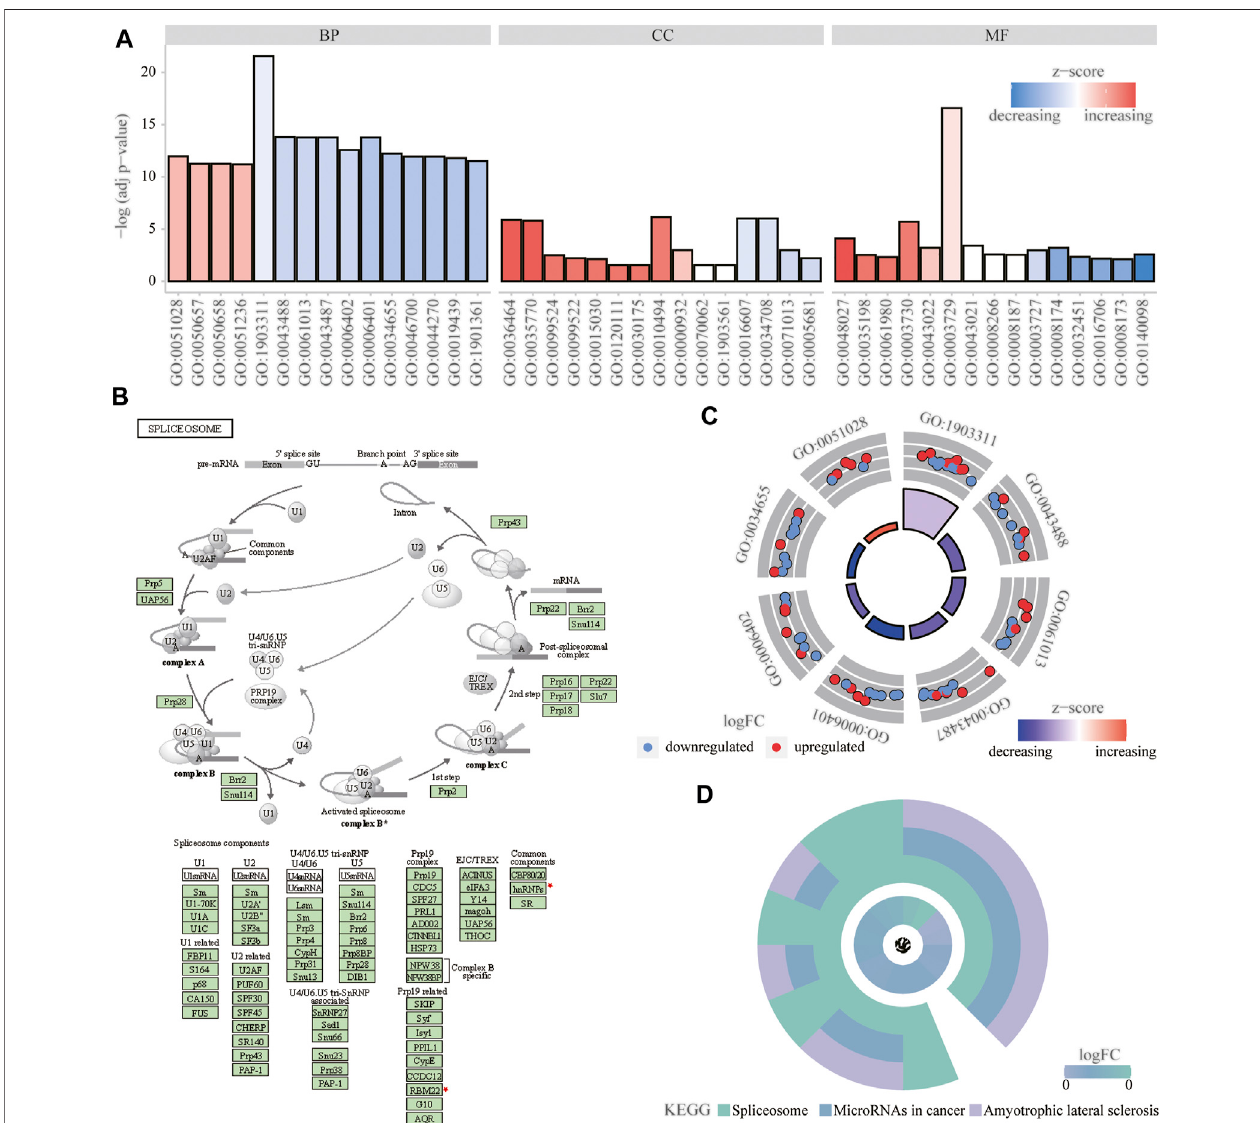
FIGURE5| Functionalenrichmentanalysisofm6Aregulator. (A) First15itemsenrichedforbiologicalprocesses,molecularfunctions,andcellularcomponentsthe abscissa represents the GO term and ordinate is the -log (adj p -value). Band colors: blue represents downregulation and red represents upregulation. (B) Signi fi cantly enriched KEGG pathway; rno03040: spliceosome. (C) m6Aregulation of the fi rst eight items of biological processes; red represents upregulation, and blue represents downregulation. (D) KEGG enrichment results; the outer circle represents the KEGG pathway and inner circle represents the log fold-change size.